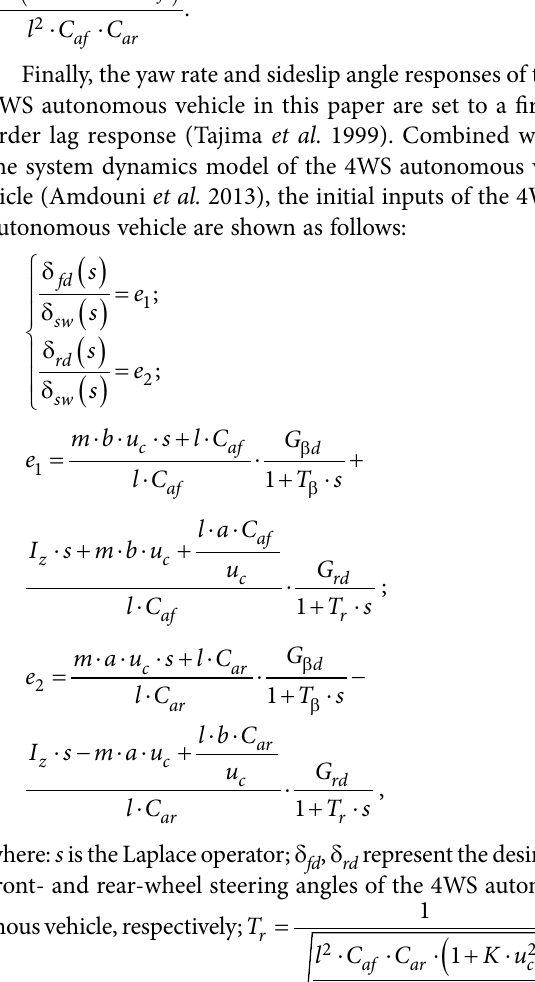
Figure 1. Circular bend with right angle (single circle center)